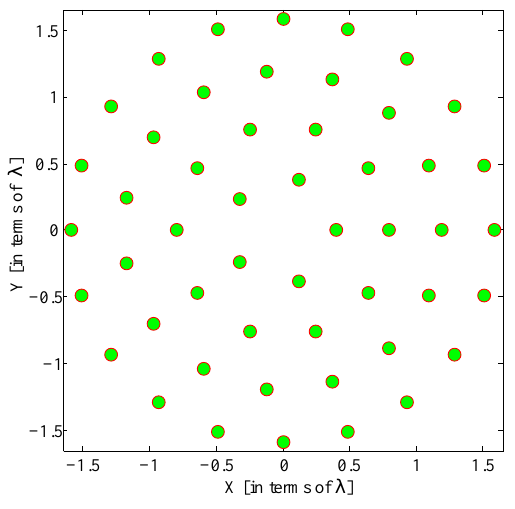
Figure 1: Geometry of concentric ring array Antenna